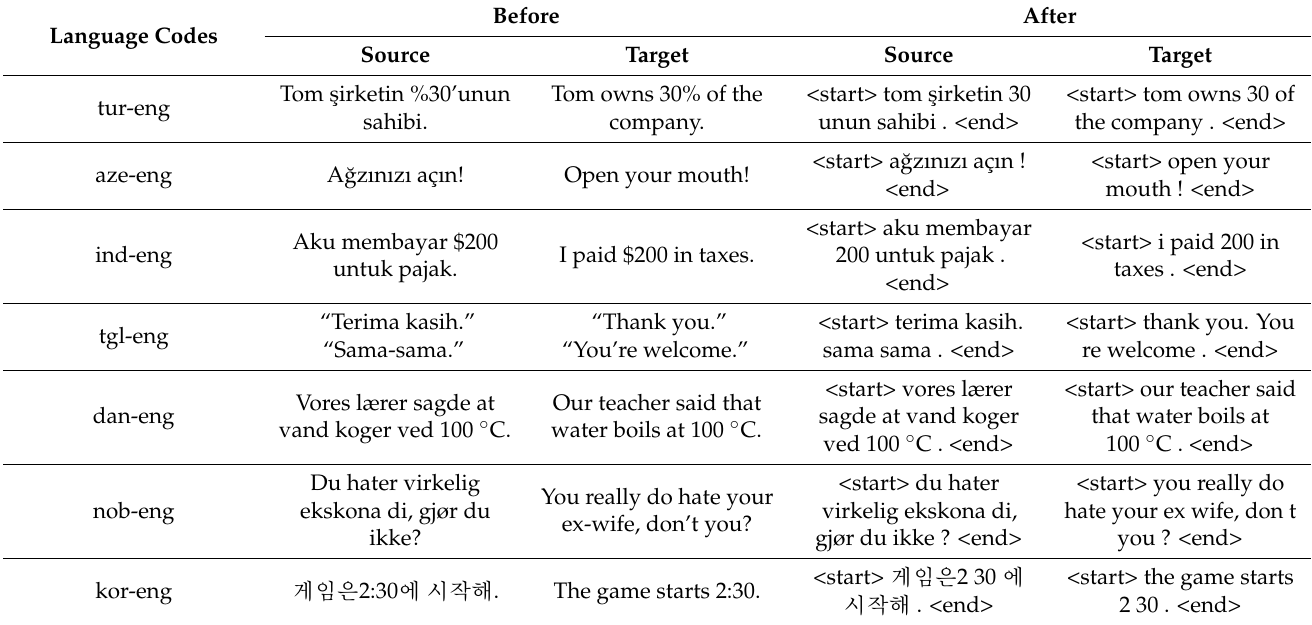
Table 2. Examples of Tatoeba Corpus before and after